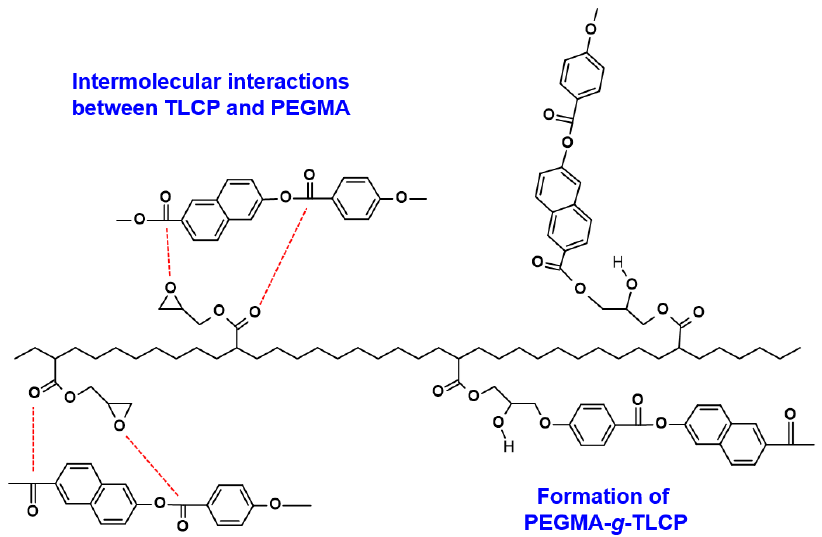
Figure 4. Schematic drawing for the formation of PEGMA- g -TLCP copolymers and the intermolecular interactions between TLCP and PEGMA in the blends.